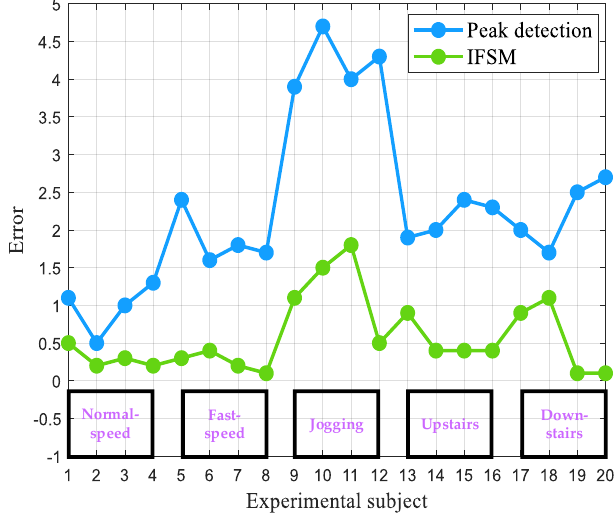
Figure 11. The error of gait detection.